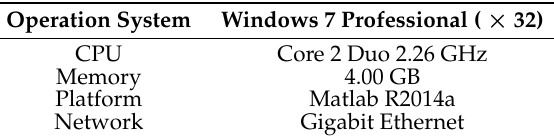
Table 3. Simulation